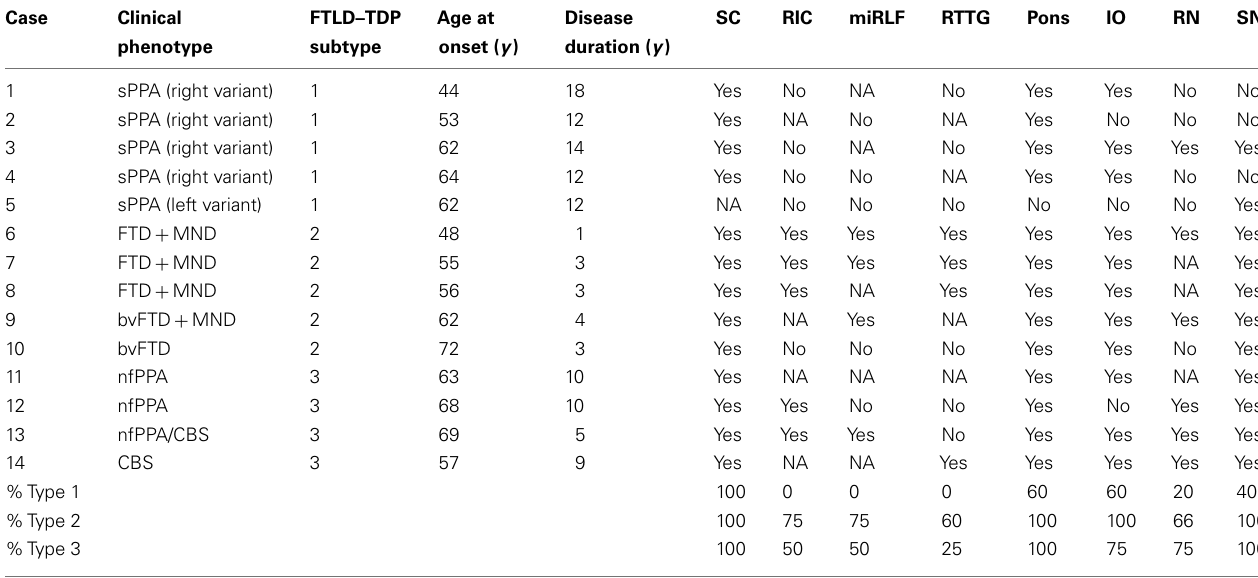
Table 1 | Summary of cases screened for